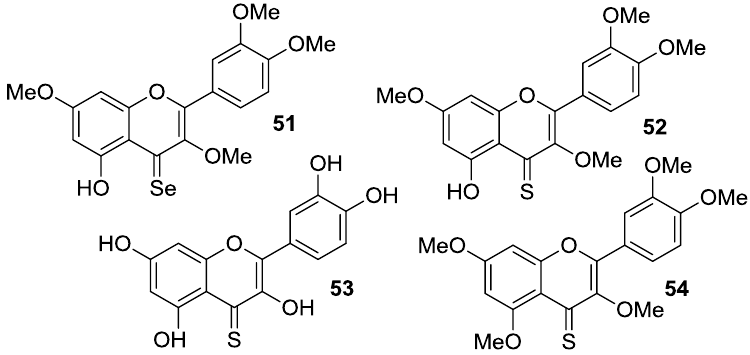
Figure 6. Structures of quercetin derivatives 51 – 54 obtained by manipulation of C-4 carbonyl moiety.